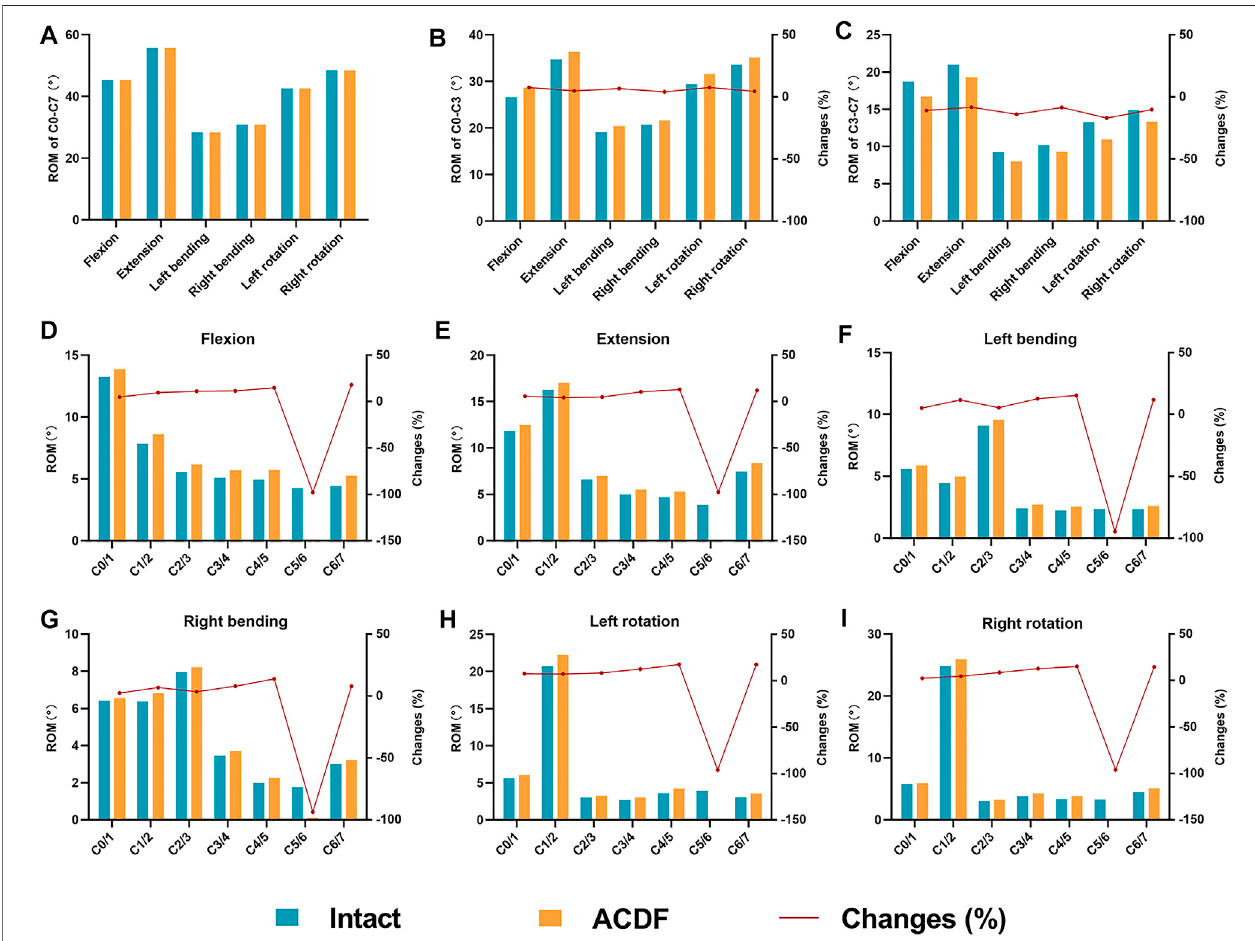
FIGURE4| ComparisonoftheROMintheintactmodelandtheACDFmodelunderthesamedisplacement (A) DisplacementloadwasappliedtotheACDFmodel under a 73.6 N follower load resulting in a total C0 – C7 ROM same as that of the intact model. (B,C) Total ROMs of the upper (C0 – C3) and the lower (C3 – C7) cervical spine (D – I) and the intervertebral ROMs of C0 – C7 in the six motion directions was shown. Note: changes (%) = (ACDF model value — intact model value)/intact model value × 100%.